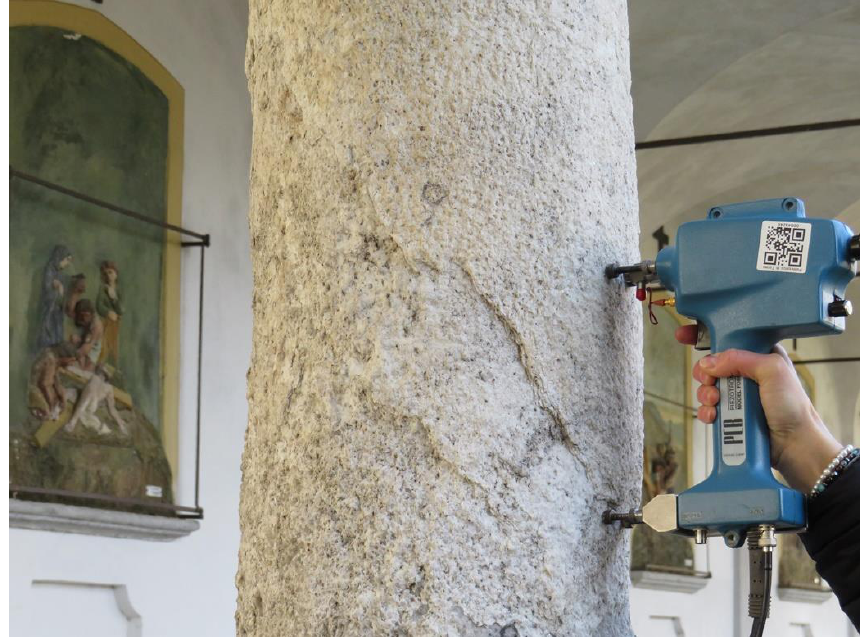
Figure 8. Impact test carried out on a column of Via Crucis portico.